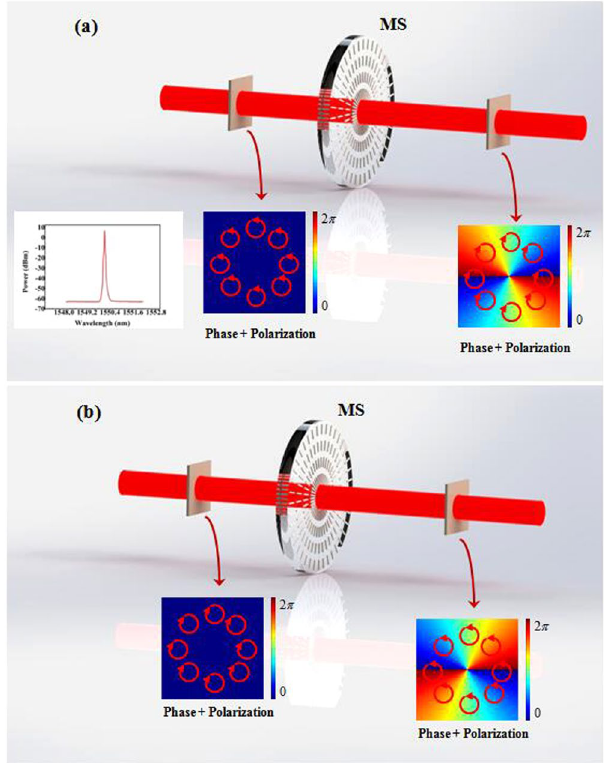
Figure 1. The conventional optical system applied to generate VBs. MS: metasurface; ( a ) A LCP (RCP) light beam illuminates the metasurface to generate VB, the optical spectrum is showed in the lower left corner. ( b ) A RCP light beam illuminates the metasurface to generate VB. Insets show the phase and polarization patterns in each step of this system.